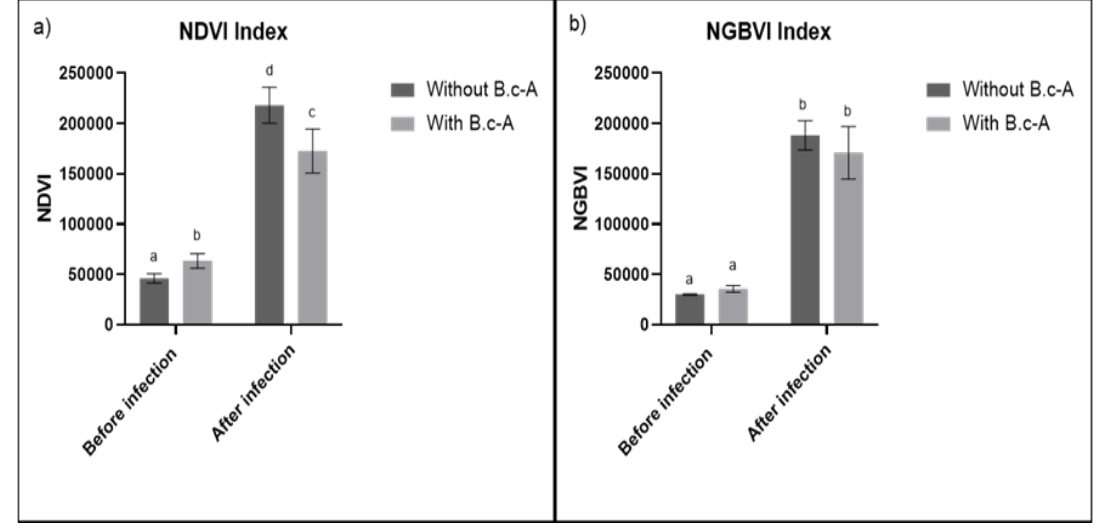
Figure 3. ( a ) NDVI values before and after infection with Cmm, ( b ) NGBVI before and after infection with Cmm. Equal letters indicate that there are no statistically representative differences. Table 2. Correlation values of the NDVI and NGBVI before and after infection with Cmm . Before Infection with Cmm Without Inoculation of B. c -A With Inoculation of B. c -A PAL CAT SOD Weight Height PAL CAT SOD Weight Height